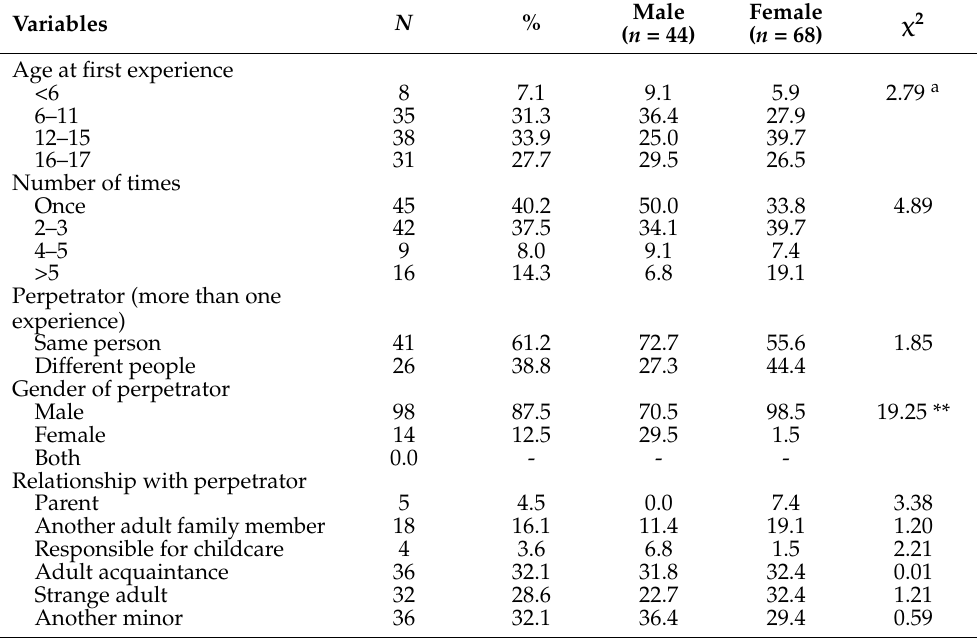
Table 4. Percentage of victims’ age at the first experience and perpetrator’s characteristics as a function of gender for “somebody asked me to touch his/her private parts”.